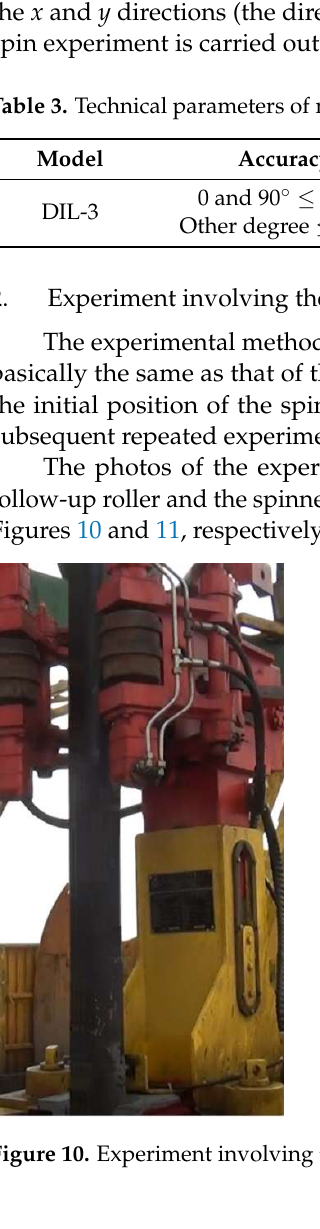
Figure 11. Experiment involving the spinner mechanism with double follow-up rollers.